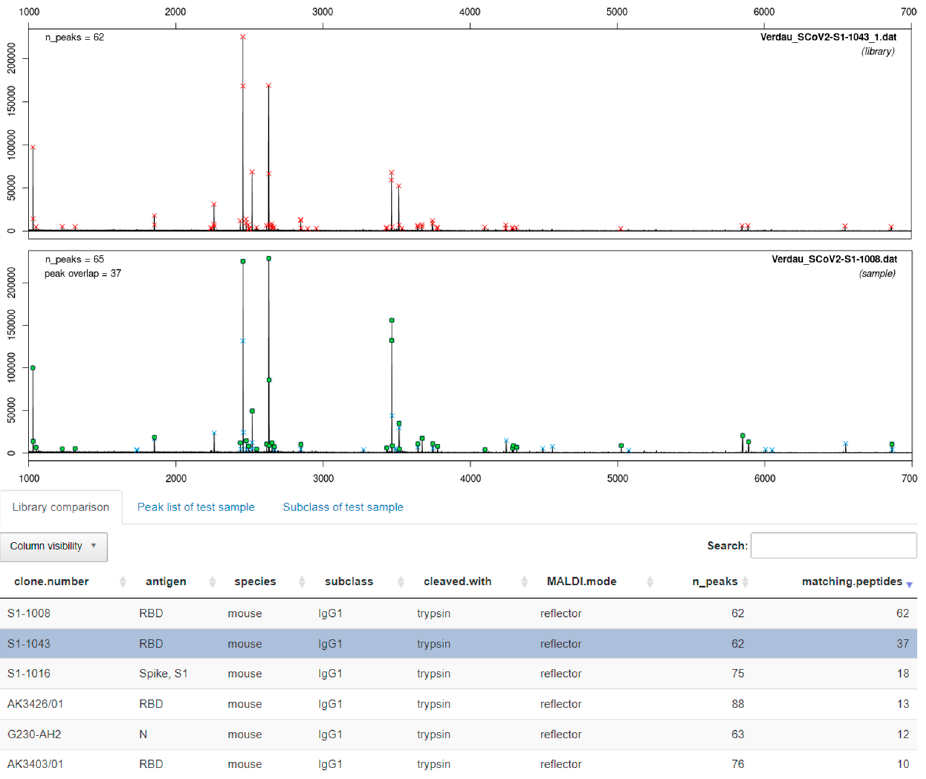
Figure 13. Screenshot of the graphical user interface of the ABID 2.0 software. The top spectrum is the library spectrum with the highest number of matching peaks with the sample spectrum (bottom spectrum). All library entries are shown in the bottom table and ranked by the number of matching peptides (last column). The software correctly identifies clone 1008 from the library as the highest match to the sample spectrum of clone 1043 with 37 matching peptides. The second-best match (S1-1016) to clone 1008 only has 18 matching